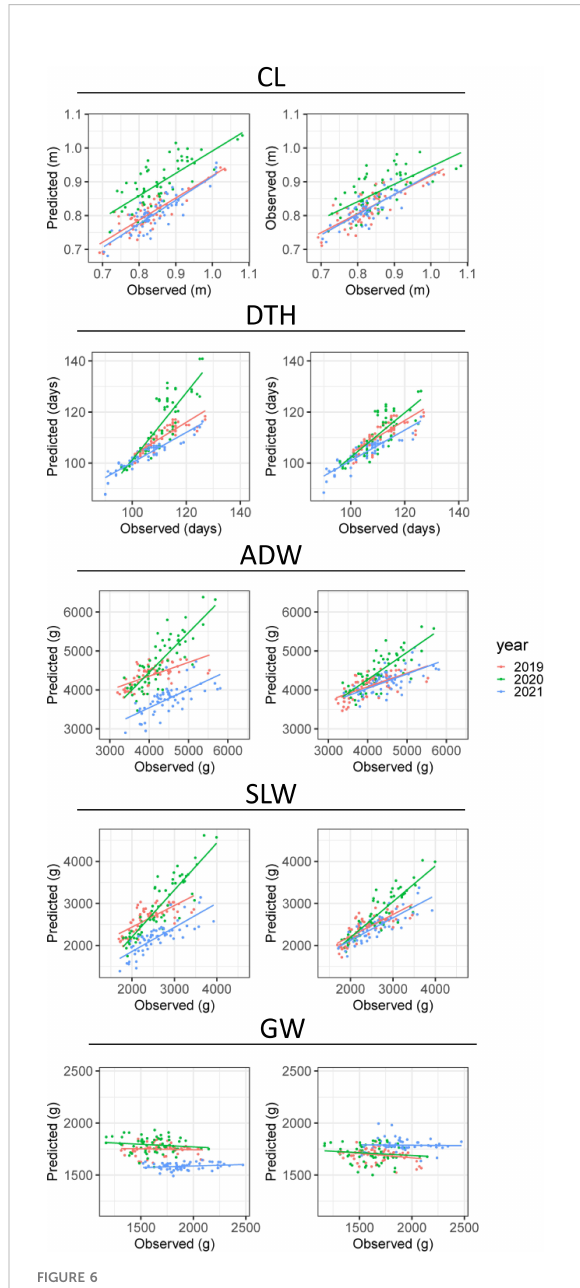
FIGURE 6 Observed and predicted values of CL, DTH, ADW, SLW, and GW. Plots show the results of CV by (left) year and (right) cultivar. The points plot datasets of predicted and observed values, colored by year; the lines are linear regressions applied to